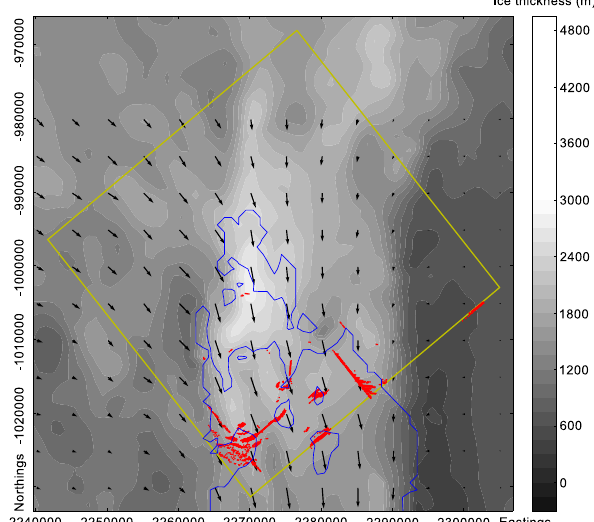
Figure 3. Modelled fractures from HiDEM at the grounding zone. Red dots show modelled crevasses. Blue line shows grounding line from HiDEM model geometry. Background greyscale shows ice thickness, and arrows indicate ice flow direction from MEaSUREs (Mouginot et al., 2017a, b). Crevasses are largely clustered around pinning points where the ice